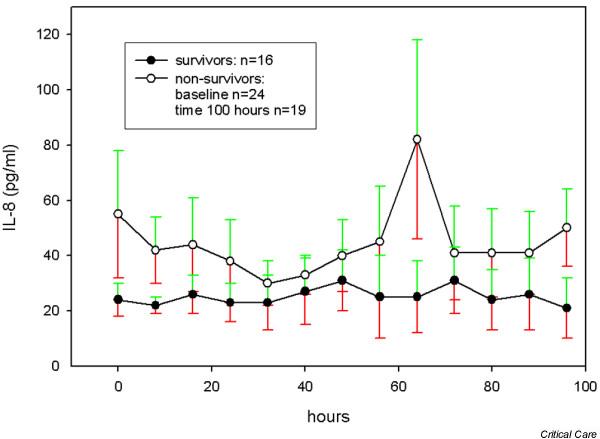
IL-8 for survivors and non-survivors over time.